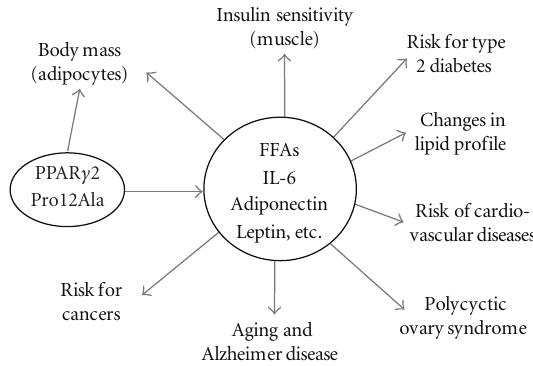
Figure 3: E ff ects of PPAR γ 2 Pro12Ala polymorphism on various aspects of human health. FFAs, free fatty acids, IL-6, interleukin 6.